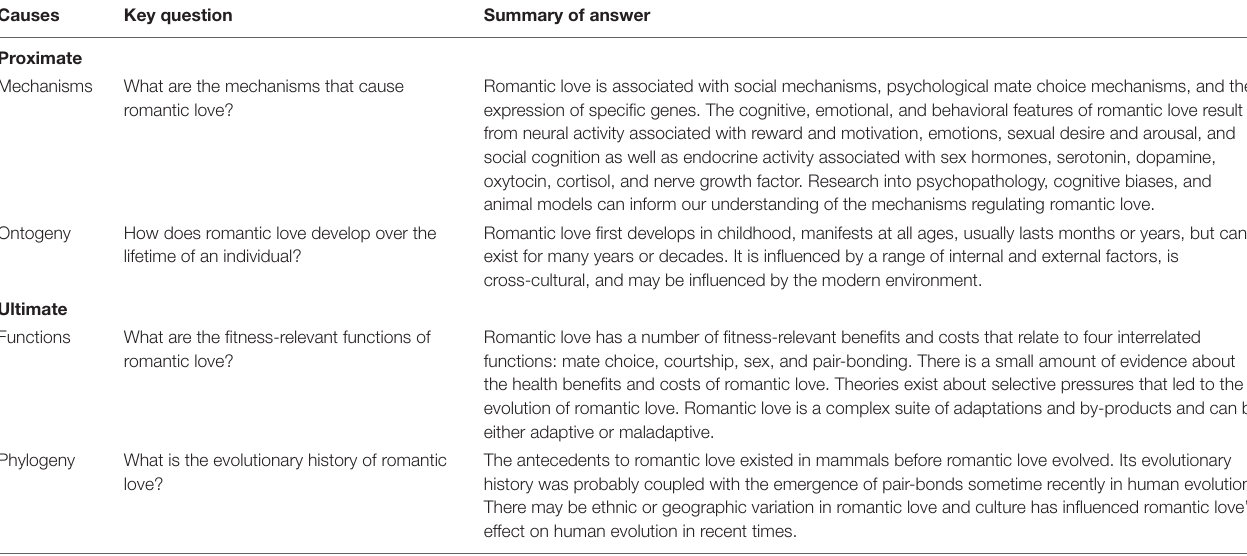
TABLE 1 | Summary of romantic love using Tinbergen’s (1963) framework.